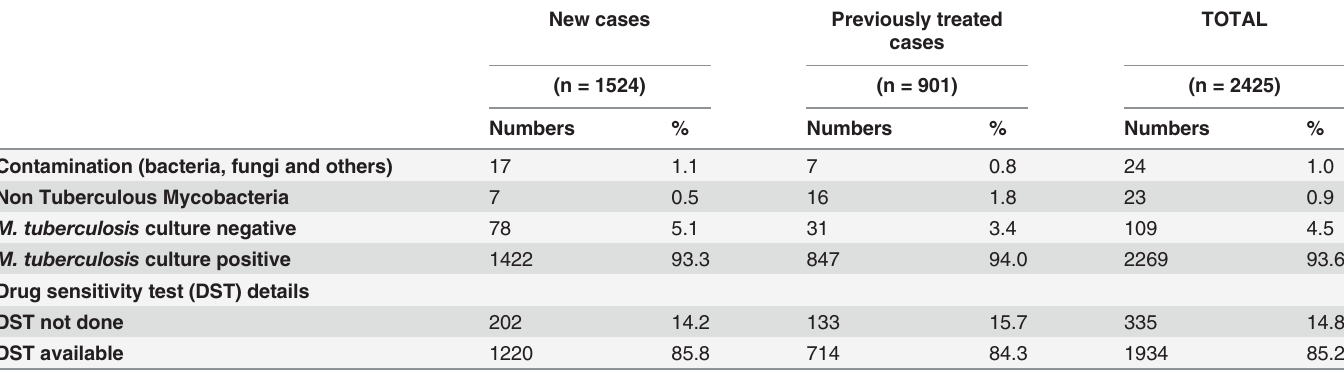
Table 1. Mycobacterial culture results from patients enrolled in the survey.